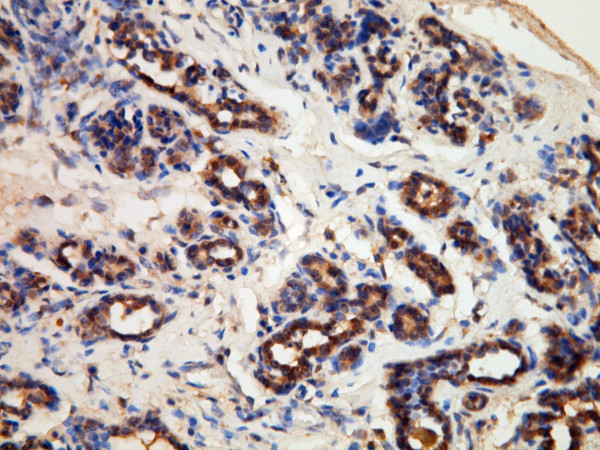
Beclin-1 expression in normal mammary glands of dogs. The normal mammary glands show diffuse moderate cytoplasmic expression and scattered nuclear expression.